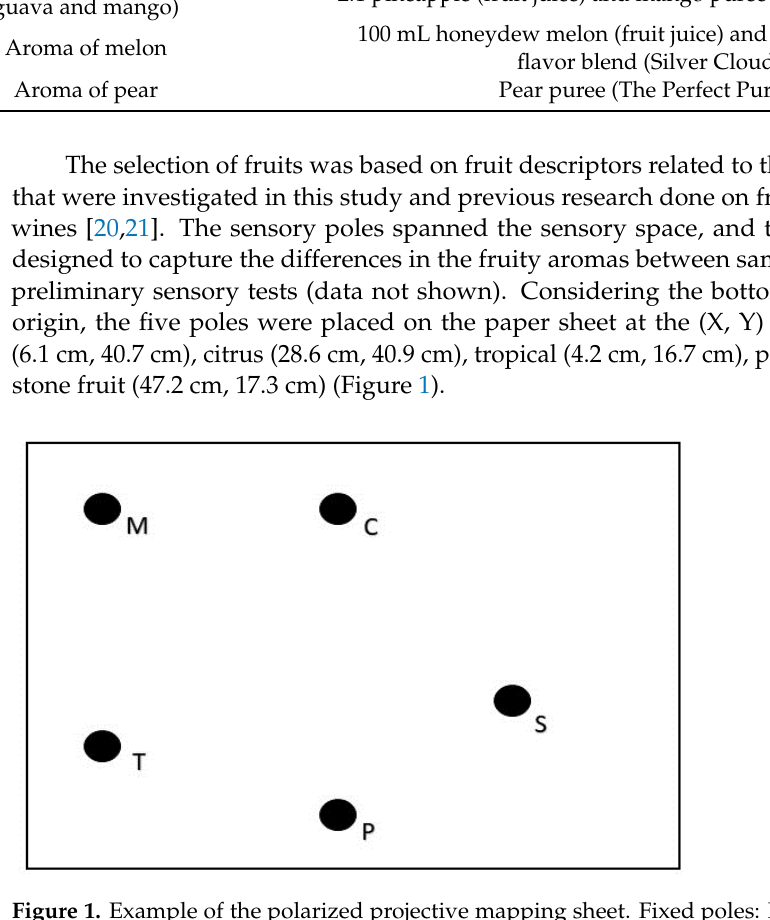
Figure 1. Example of the polarized projective mapping sheet. Fixed poles: M = melon, C = citrus, T = tropical fruit, P = pear, S = stone fruit.